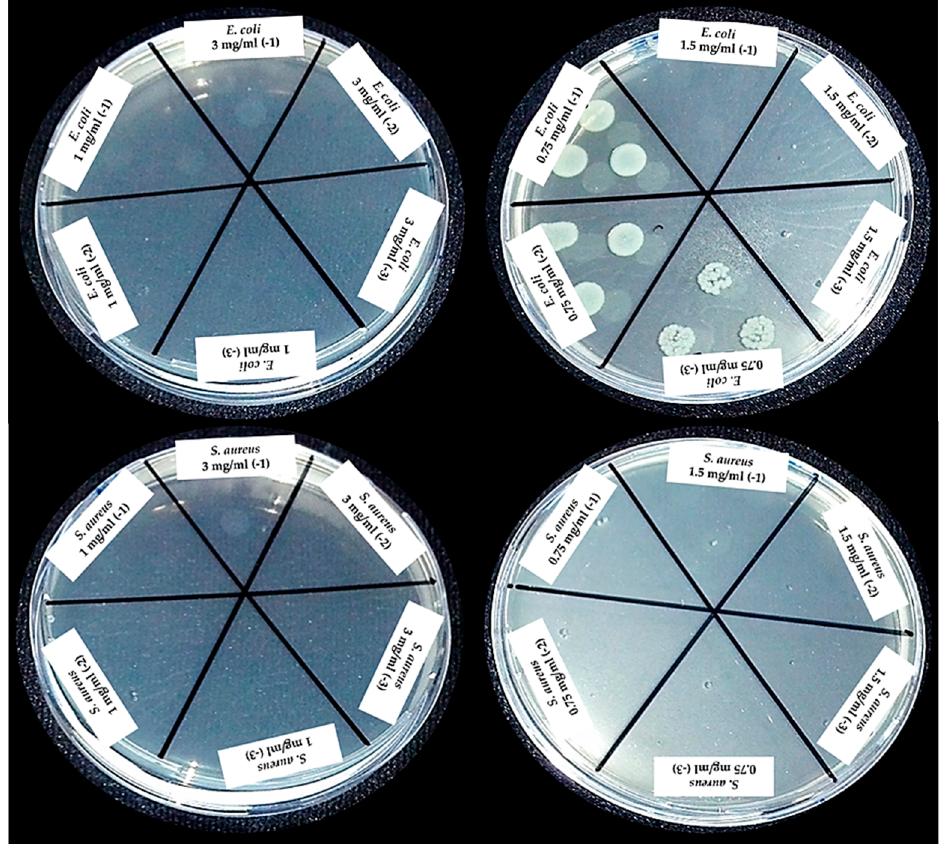
Figure 11. Bacterial count by the microdrop technique and determination of the antibacterial activity of nZH-Cu against reference strains of E. coli and S. aureus .